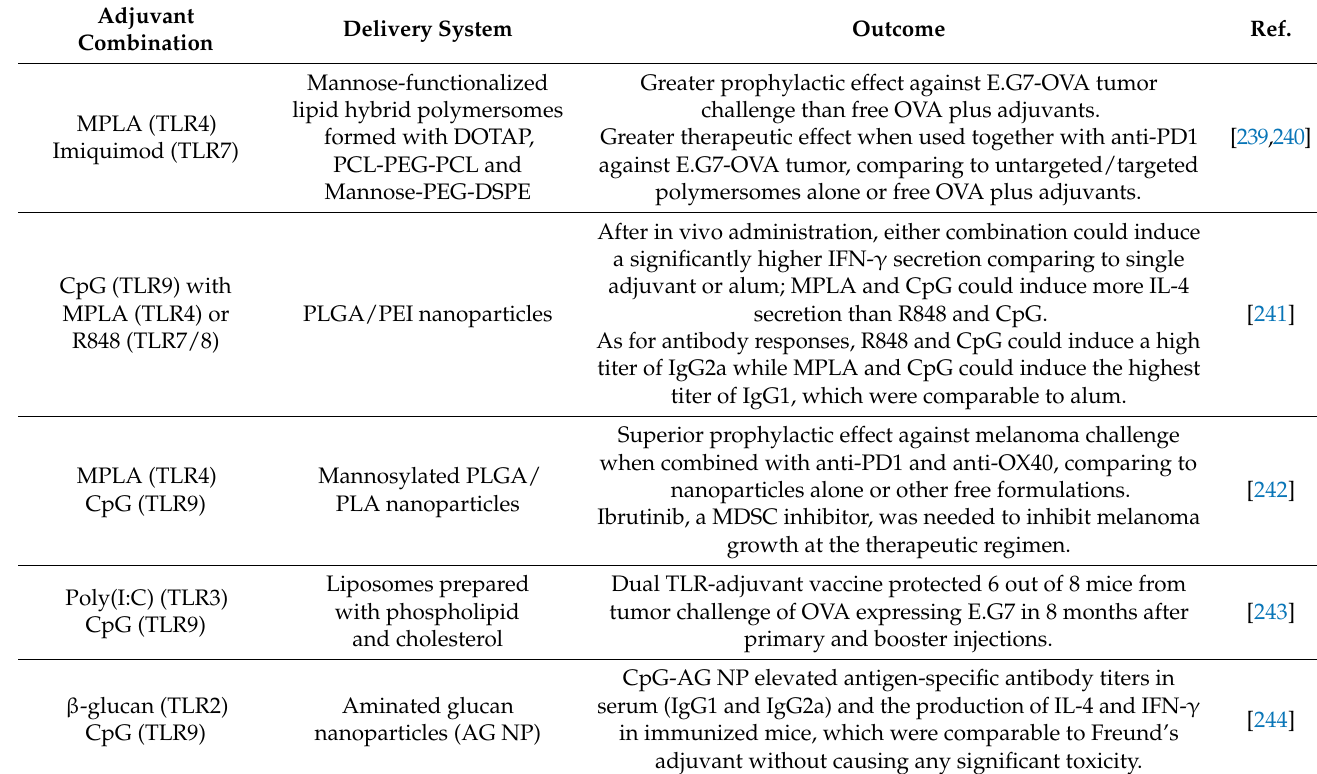
Table 3. Vaccines with combined